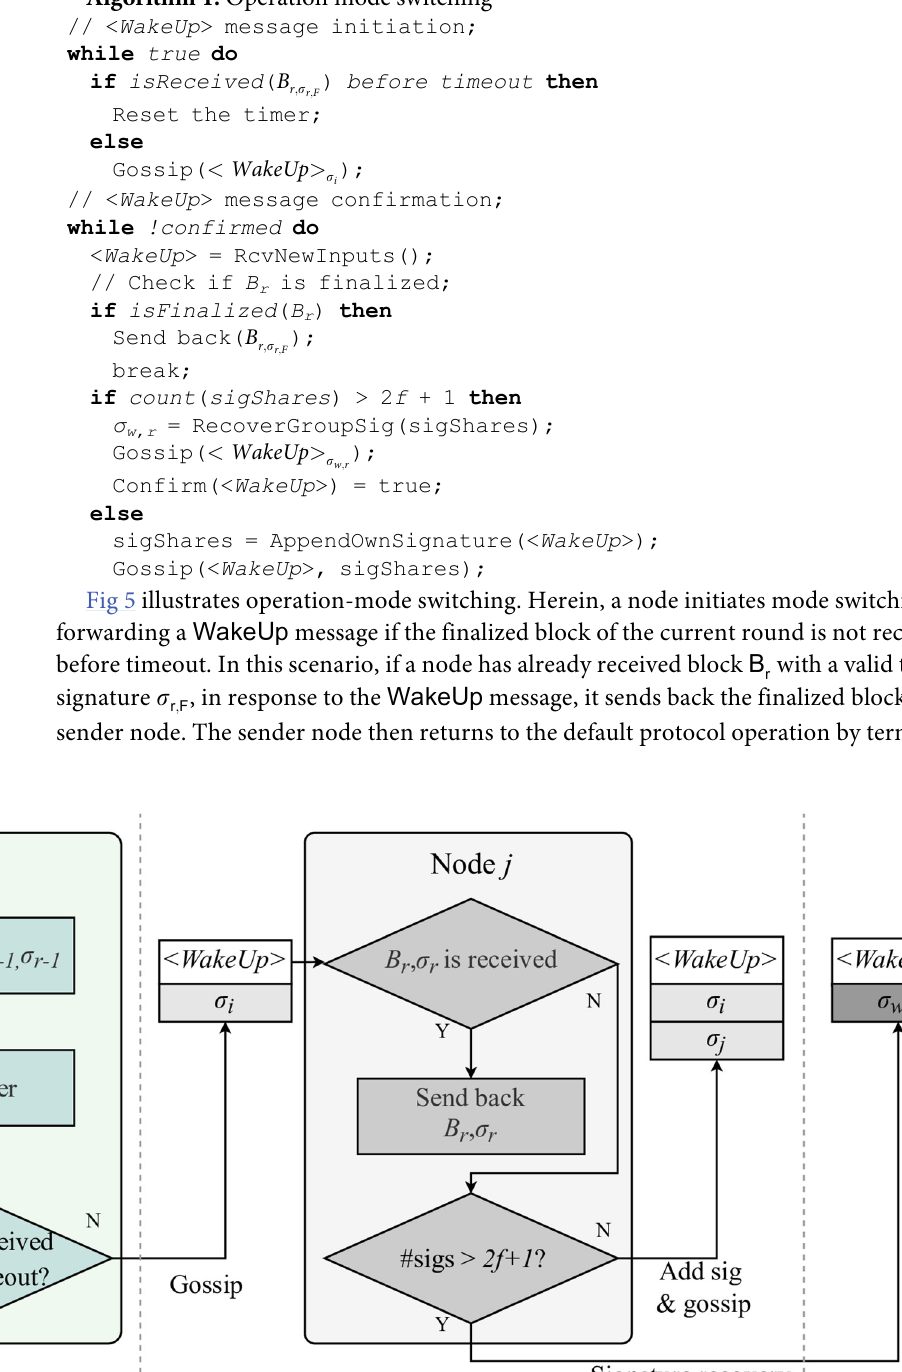
Algorithm 1: Operation mode switching